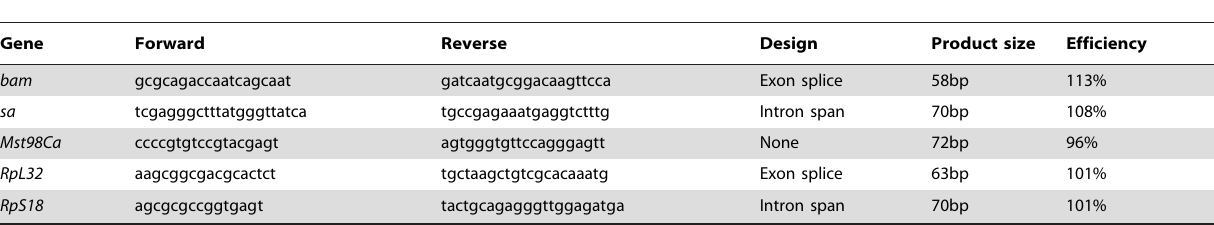
Table 1. Primers used in this